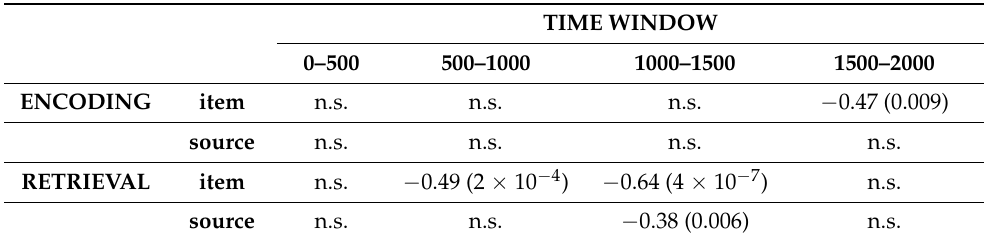
Table 2. Overview of Pearson’s correlations between beat stimulation-related (BB-MB) and memory- related (REM-FORG) firing rate differences in the post-stimulus windows.